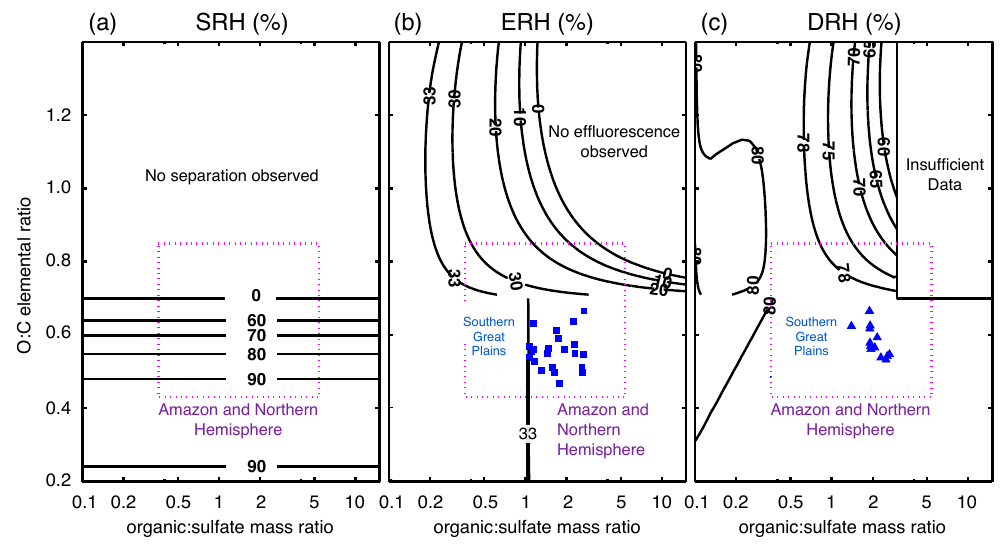
Fig. 4. Contour plots of SRH, ERH, and DRH based on the presented parameterisations of the experimental data. The magenta boxes enclose org:sulf and O:C values (campaign averages) measured in the pristine Amazon Basin ( Chen et al., 2009) and many locations in the Northern Hemisphere (Jimenez et al., 2009; Ng et al., 2010). The blue symbols in (b) and (c) correspond to field measurements of ERH and DRH that were carried out at the Southern Great Plains (SGP), Oklahoma, USA (Martin et al., 2008). Since instruments commonly used to measure phase transitions in the field are not capable of directly measuring liquid-liquid phase separations, there are no field observations included in (a) . Contours apply to temperatures ranging from 290 to 298